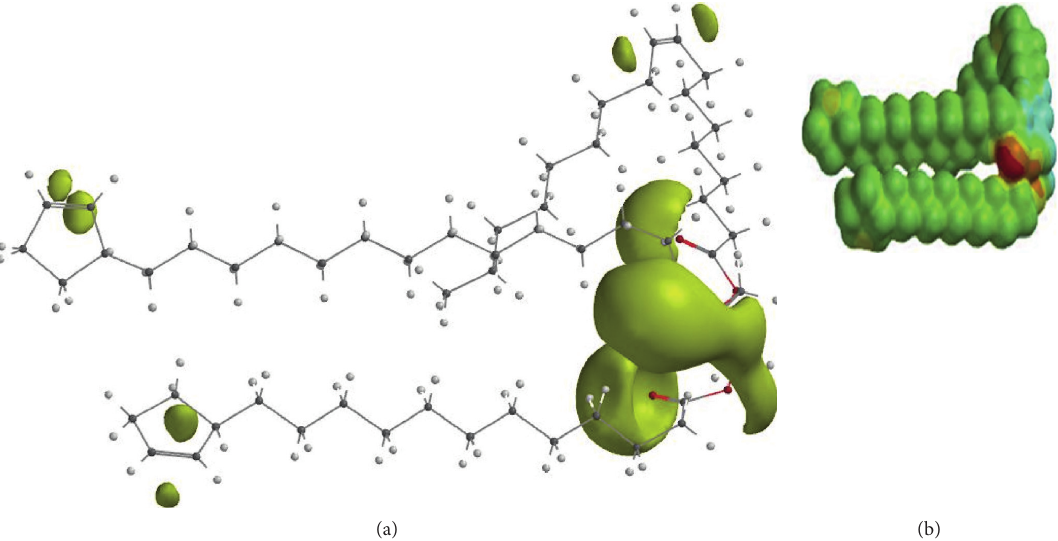
Figure 8: (a) Electrostatic potential map of a typical molecule of chaulmoogra oil; (b) potential mapping on density surface.